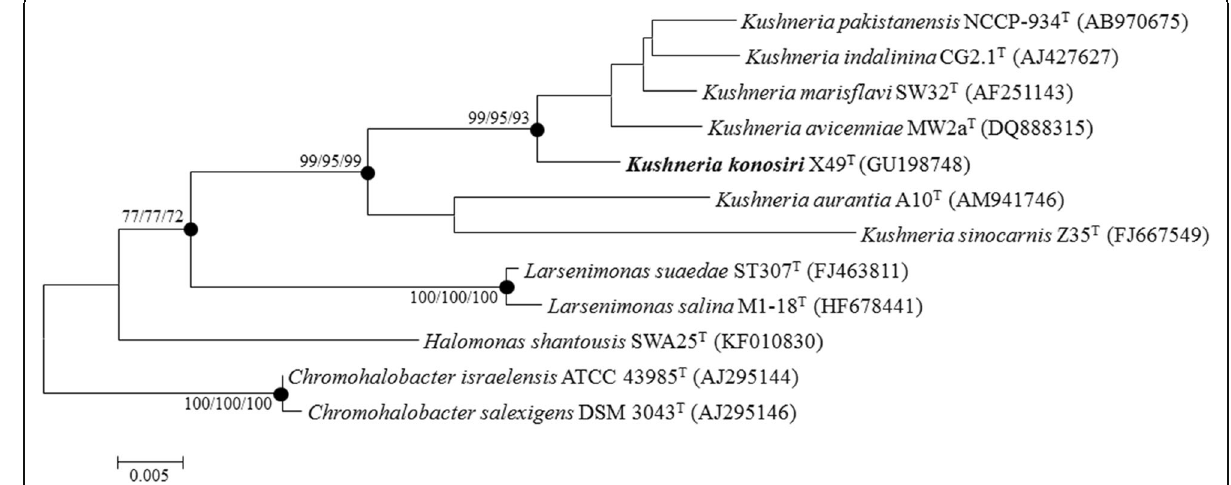
Fig. 1 Neighbor-joining phylogenetic tree based on 16S rRNA gene sequences of K. konosiri X49 T and closely related taxa. Numbers at nodes indicate bootstrap values (over 70%, 1000 replicates) for neighbor-joining, maximum-likelihood, and maximum-parsimony. Closed circles indicate the nodes that were also generated by maximum-likelihood and maximum-parsimony. Scale bar, 0.005 accumulated changes per